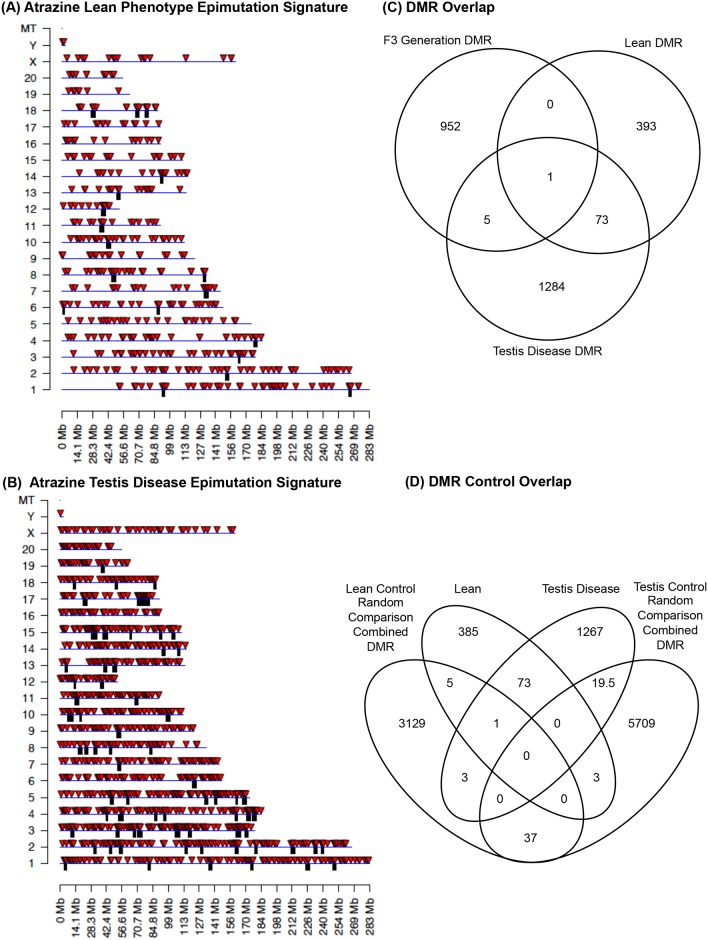
Pathology associated DMRs (epigenetic biomarker signatures).(A) Atrazine DMR chromosomal locations for the lean versus non-lean comparisons within the F3 generation atrazine lineage populations. All DMRs at a p-value threshold of 1e-05. (B) Atrazine DMR chromosomal location on individual for the testis versus non-testis comparisons within the F3 generation atrazine lineage population. (C) DMR overlap between the lean DMRs, testis disease DMRs and original total F3 generation atrazine versus control lineage DMR. (D) DMR overlap between the lean and testis disease DMR signatures and the atrazine population random permutation comparisons combined DMR dataset.